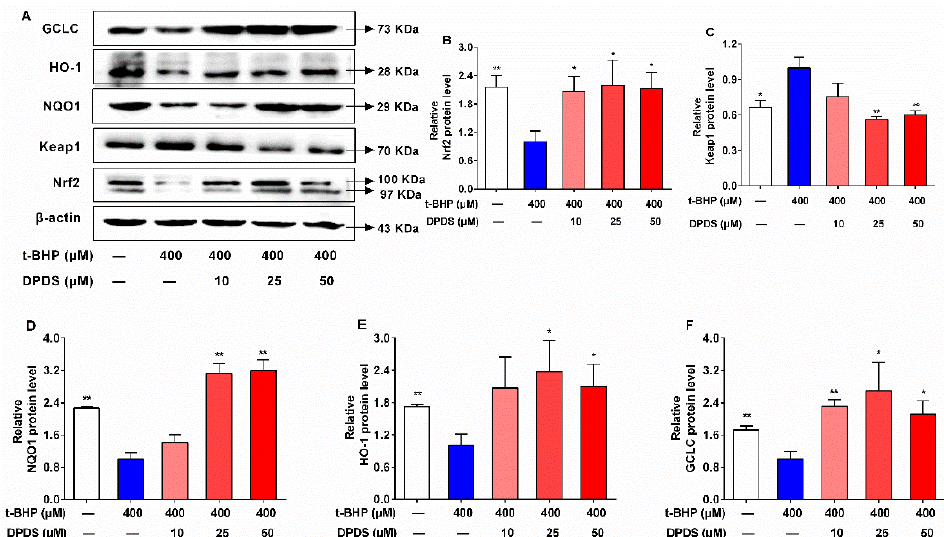
Figure 3. DPDS activated the Nrf2/Keap1 signaling pathway in t-BHP-stimulated HBZY-1 cells. HBZY-1 cells were exposed to t-BHP (400 µ M) alone or in combination with DPDS (10, 25 or 50 µ M) for 24 h. ( A ) Representative protein band of Nrf2, NQO1, HO-1 and GCLC. ( B ) The relevant quantitative data of Nrf2 expressed as fold of t-BHP group. ( C ) The relevant quantitative data of Keap1 expressed as fold of t-BHP group. ( D ) The relevant quantitative data of NQO1 expressed as fold of t-BHP group. ( E ) The relevant quantitative data of HO-1 expressed as fold of t-BHP group. ( F ) The relevant quantitative data of GCLC expressed as fold of t-BHP group. Values are presented as means ± SEM, n = 4. * p < 0.05, ** p < 0.01 versus the 400 μ M t-BHP group.